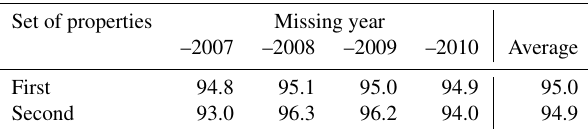
Table 7. As in Table 6 but for the second CA. Here, no runs occurred where less than 91% of stations were assigned to the same cluster as in the reference run.